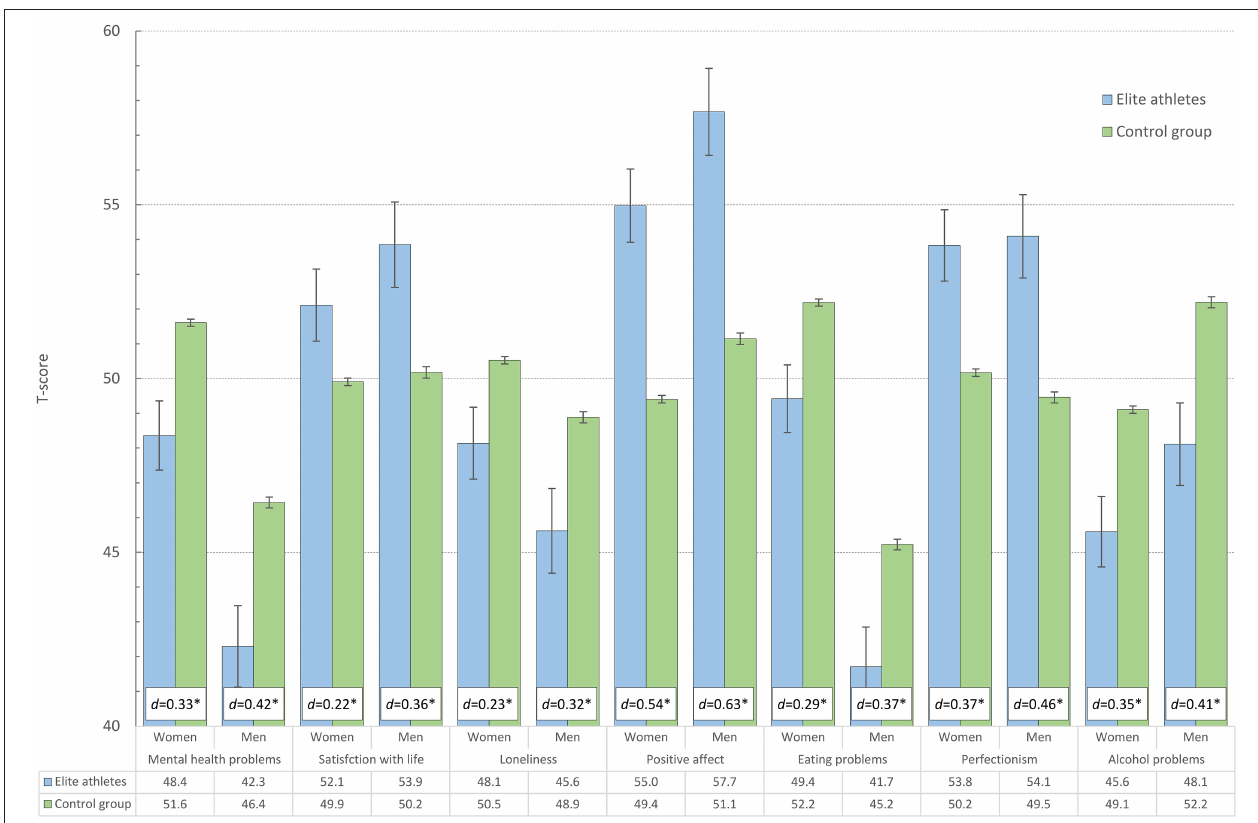
FIGURE 1 | Health indicators among elite athletes and control group in male and female college and university students (age-adjusted estimates represented in T-scores and Cohen’s d effect size (in white text box). Error bars represent 95% confidence intervals. * p <